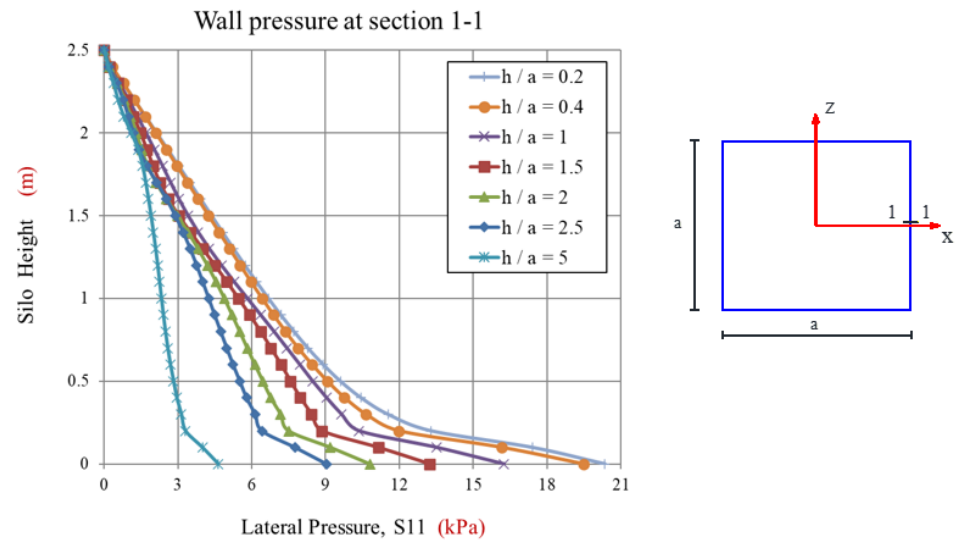
Figure 12. Lateral wall pressure for different flexible silo dimensions (a = 0.5–12.5 m, h = 2.5 m).